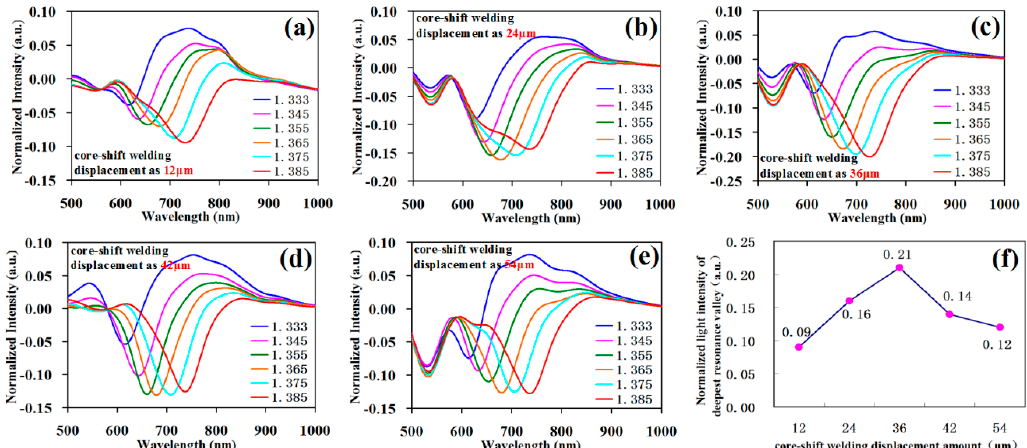
Figure 9. The SPR testing data with different displacements of the core-shift welding. ( a ) The experimental data of the core-shift welding displacement of 12 μ m; ( b ) the experimental data of the core-shift welding displacement of 24 μ m; ( c ) the experimental data of the core-shift welding displacement of 36 μ m; ( d ) the experimental data of the core-shift welding displacement of 42 μ m; ( e ) the experimental data of the core-shift welding displacement of 54 μ m; ( f ) normalized light intensity of the deepest resonance valley corresponding to the core-shift welding displacement.